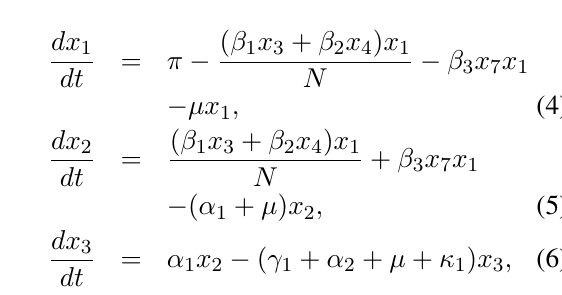
where ψ H depends on household size and ψ represents asymptomatic or symptomatic status of the infection. An individual in the household h is also exposed to community transmission because a member of the household has to leave the house to transact with the community, for example to buy food or to go to work (if they are front-line workers) during the lockdown. This movement is inevitable in poverty stricken Africa where food insecurity is common and food must be sourced daily. The rate of community exposure is given by: